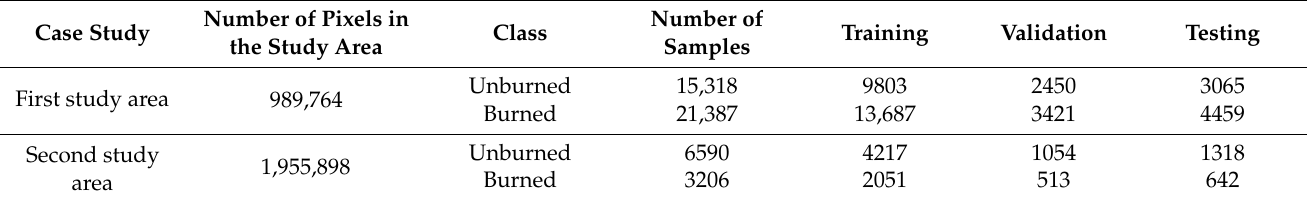
Table 2. The number of samples used for mapping of burned area in the two study areas.